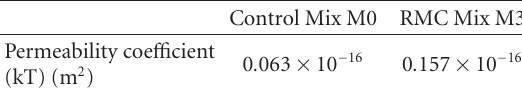
durable and have more freeze-thaw resistance. Entrained air produces discrete, nearly spherical bubbles in the cement paste so that no channels for the flow of water are formed and the permeability of the concrete is not increased [35].